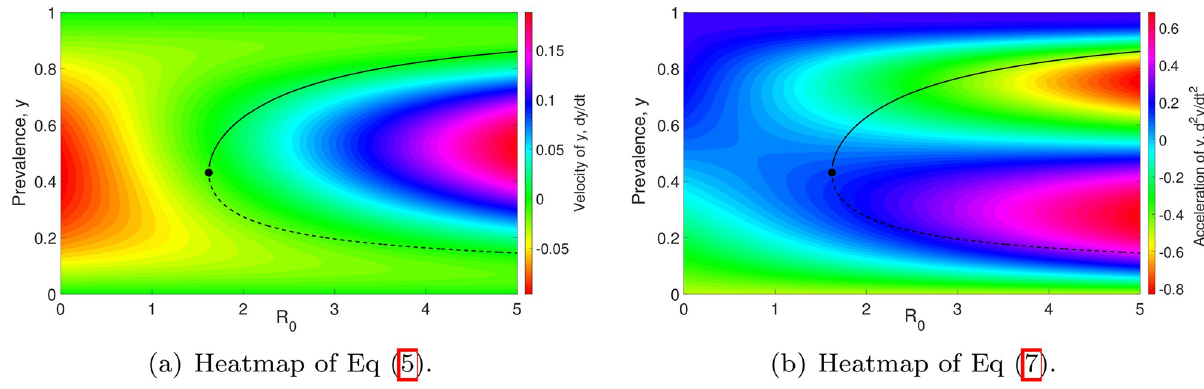
Fig 6. Heatmaps of the vector field (5) and the rate of change of the model (5)—i.e., Eq (7)—are as shown in subfigures (a) and (b), respectively. k = 0.5 and z = 0.96 are chosen to generate these two